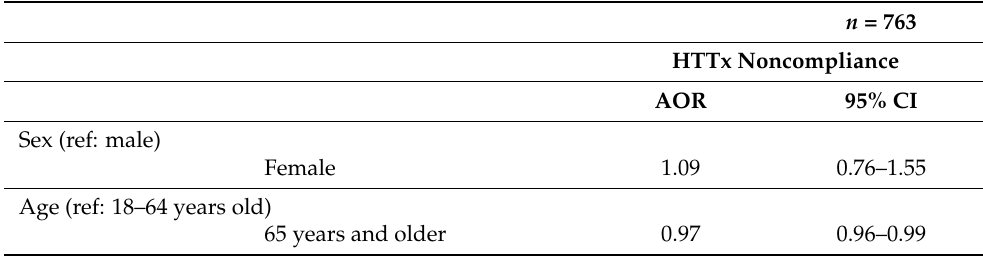
Related factors of hypertension treatment (HTTx) noncompliance (binary logistic regression